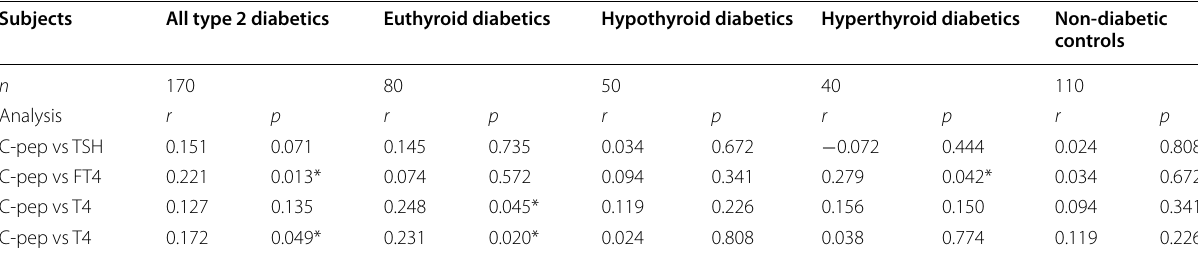
Table 3 Correlation analysis between C-peptide and thyroid hormones in all type 2, euthyroid, hypothyroid and hyperthyroid type 2 diabetics and non-diabetic subjects